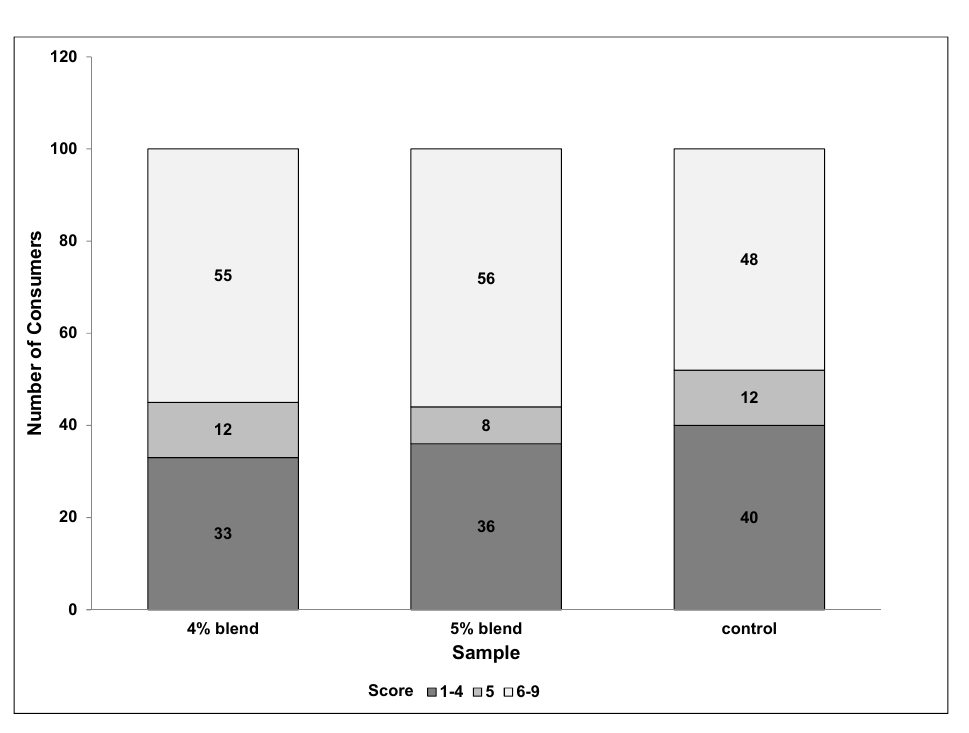
Figure 1. Overall liking score groupings based on frequency of response.